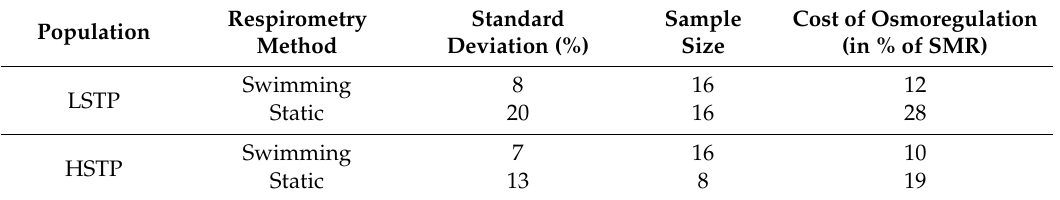
Table 2. Analyses of the detectable level of cost of osmoregulation of the present study, defined as an added metabolic cost at a salinity of 0 relative to at a salinity of 10. The statistical power cut-o ff value was set to 0.8. The analyses were done for both swimming and static respirometry determinations of standard metabolic rate (SMR) on European perch ( Perca fluviatilis ) from a low salinity tolerance population (LSTP) and a high salinity tolerance population (HSTP).